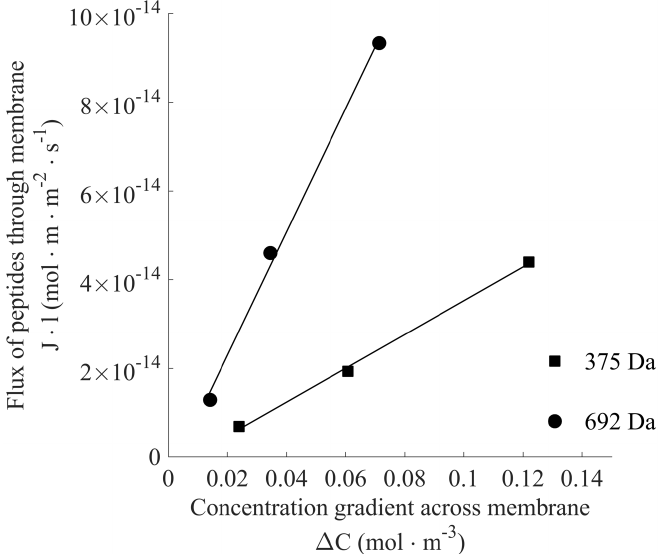
Figure 3. Molar flux of peptides across the membrane. The graph shows the molar peptide flux over the membrane as a function of the concentration gradient across the membrane. Each concentration point is a mean value of triplicate experiments at that concentration. The slope of the graph gives the membrane permeability for each peptide. The linear regression coefficients are 0.99792 (375 Da) and 0.99817 (692 Da).